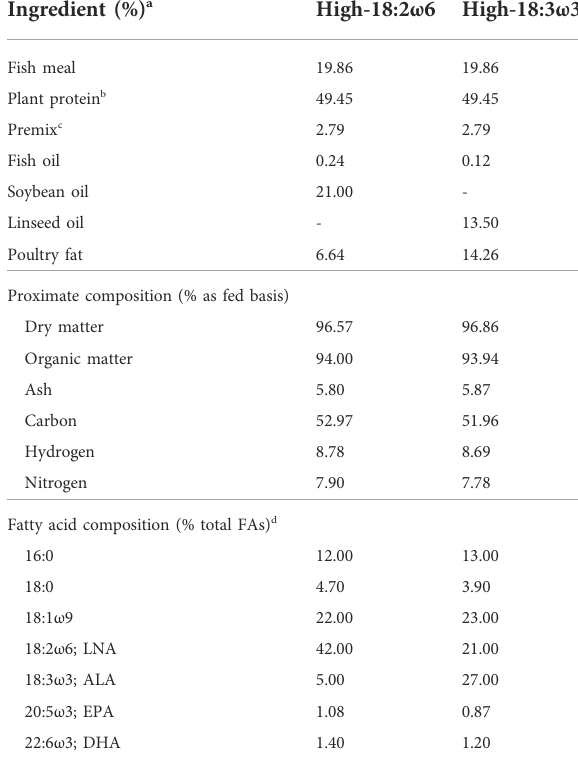
TABLE 1 Formulation and fatty acid composition of the experimental diets fed to Atlantic